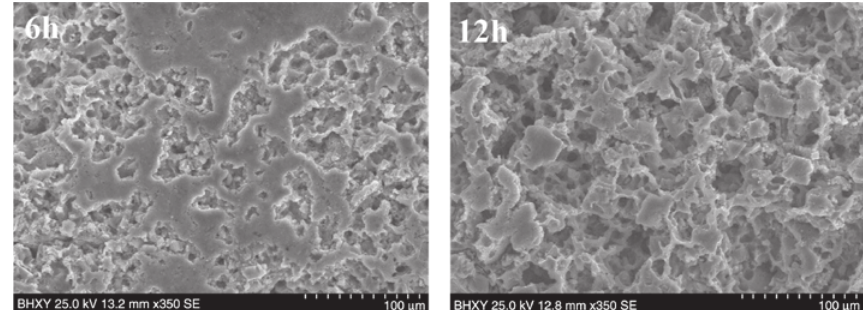
Figure 8: Micro-morphologies of degradable composite at different time in 3 wt.% KCl